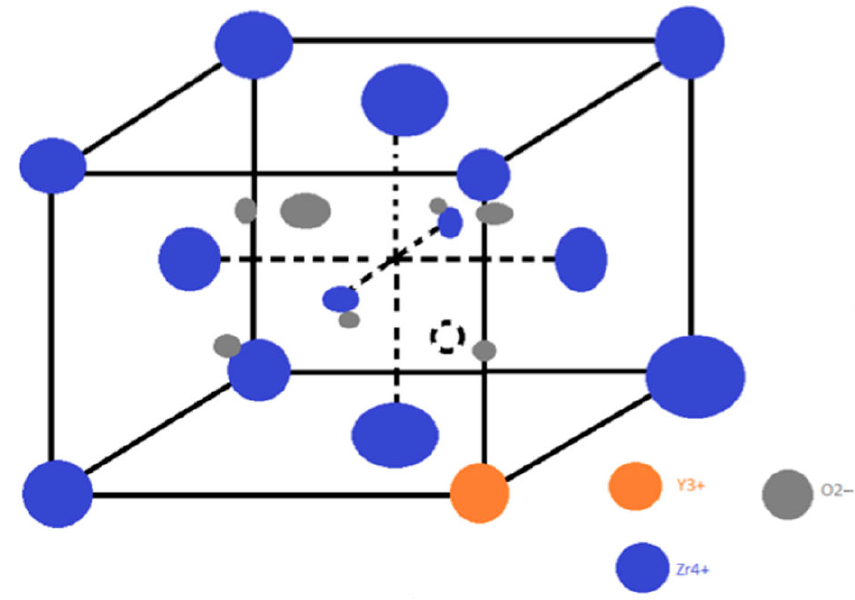
Figure 3. The yttria-stabilized zirconia